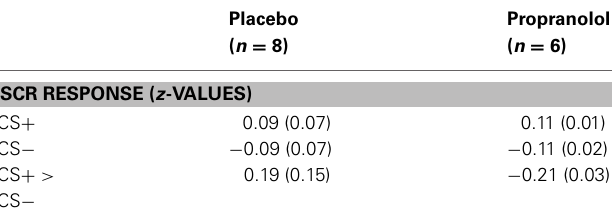
Table 5 | SCR responses from the emotional learning task.